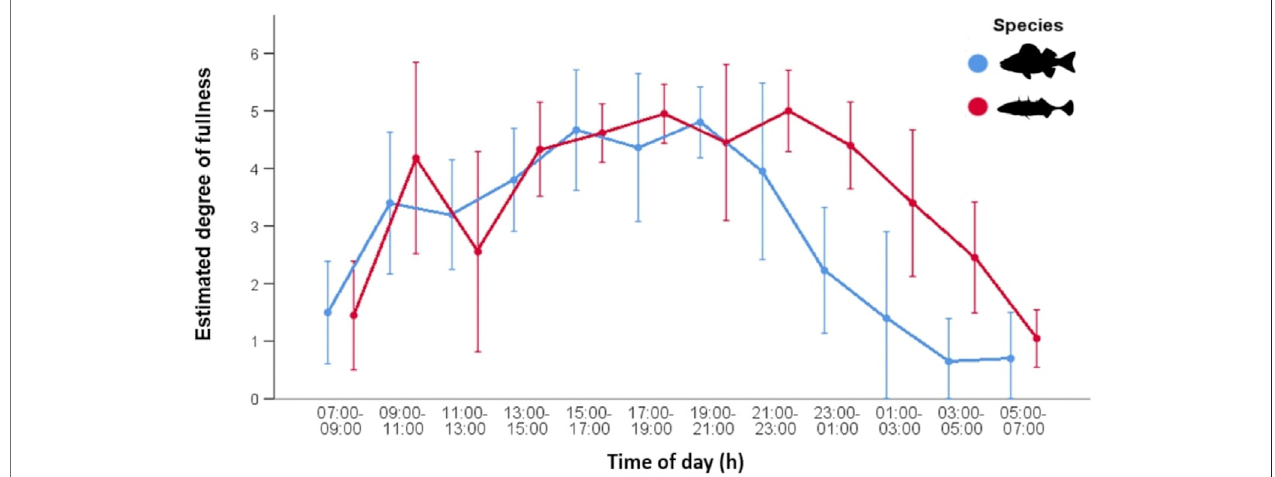
FIGURE 3 | Stomach fullness (mean ± SD) of stickleback ( N (cid:2) 203) and perch ( N (cid:2) 220) from Lake Constance during the 24-h cycle in autumn. Values were estimated from 0 (empty) to 6 (distended/stuffed).